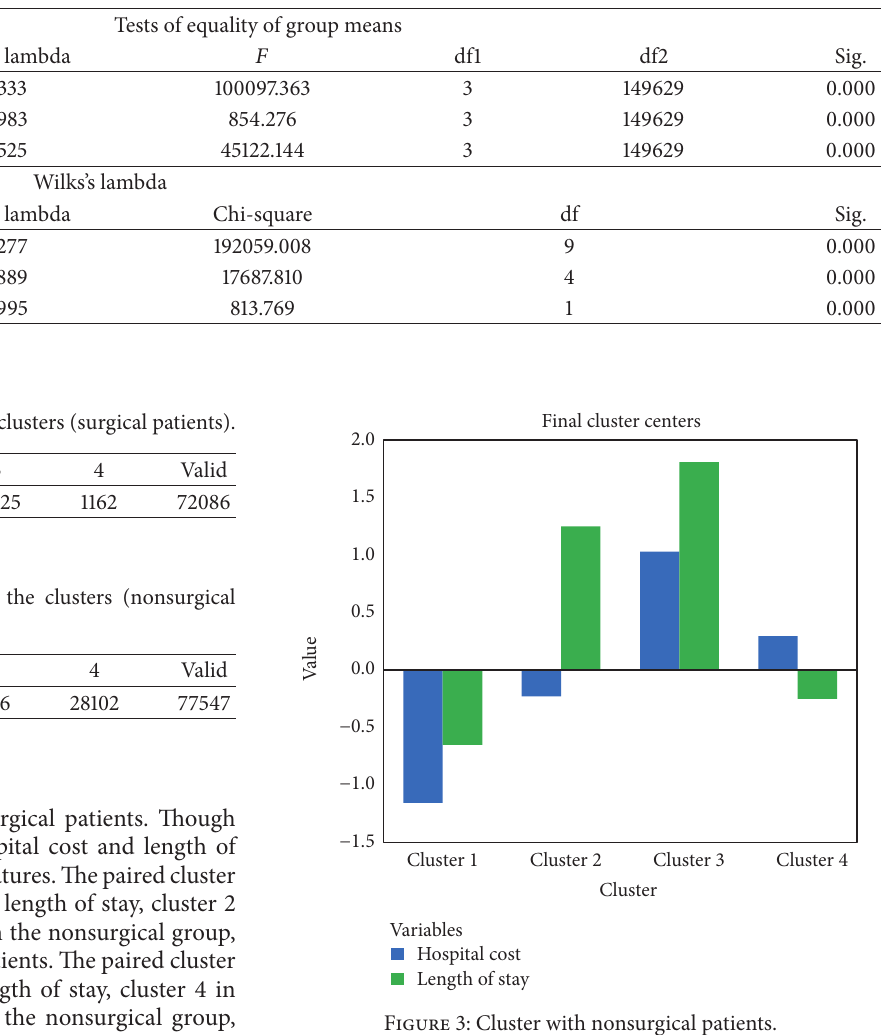
Table 4: Validity test in discriminant analysis.